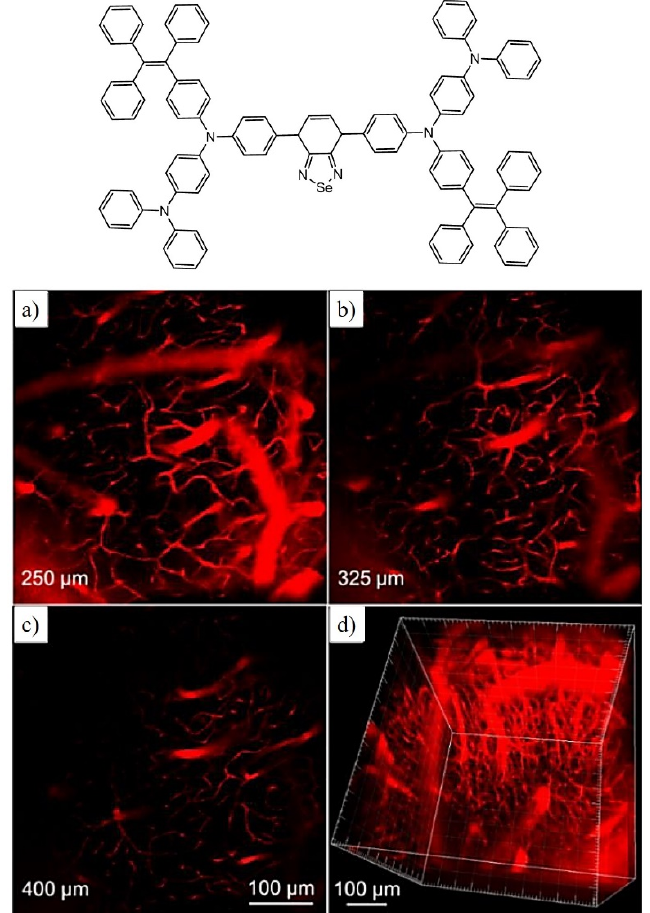
Figure 11. Representative molecular structure with fluorescent images captured under two-photon imaging technique for brain blood vessels upon incubation of mouse cells for 0.5 h with TTSe dots ( a – c ). ( d ) represents a high-resolution 3-D image of blood vessels at 100 μ M scale. Reprinted from reference [81] with the permission of The Royal Society of Chemistry.